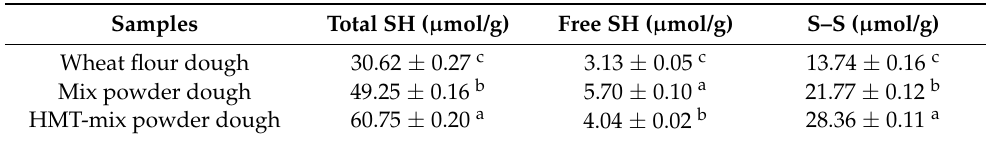
Table 4. Total sulfhydryl groups (total SH), free sulfhydryl groups (free SH) and disulfide bonds (S–S) of dough from wheat flour, mix powder and HMT-mix powder.